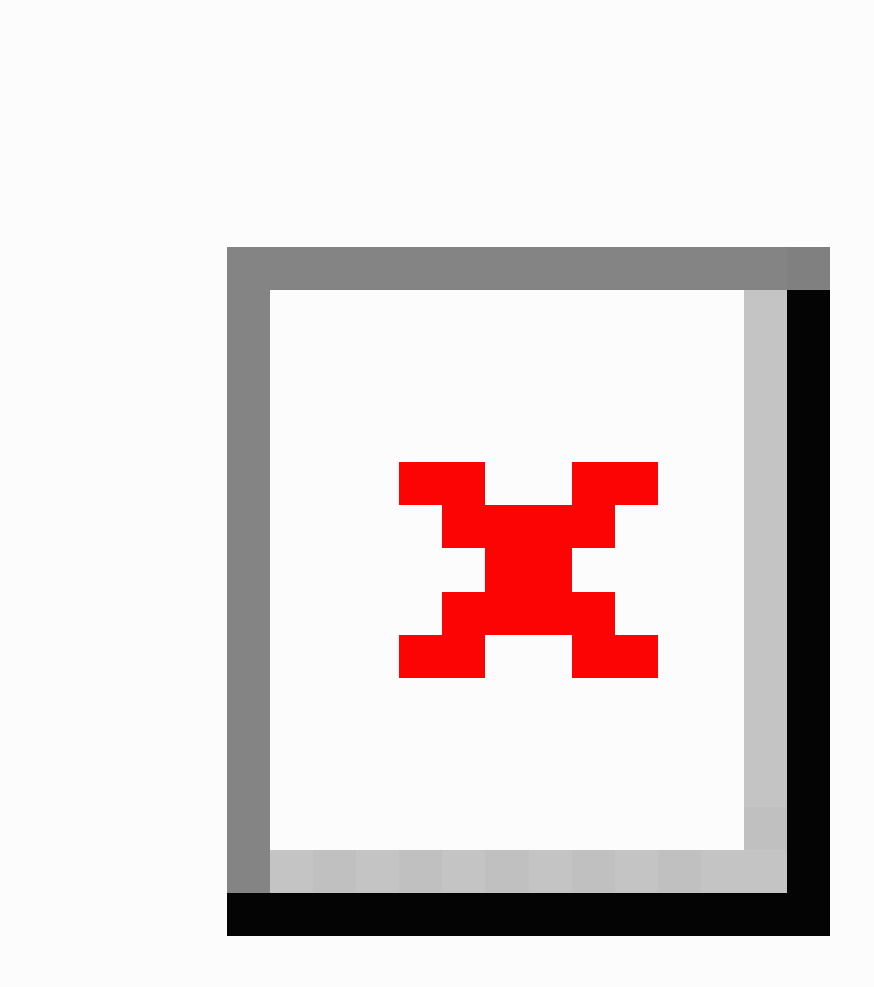
Figure 1. Diet app use by sports dietitian’s country of